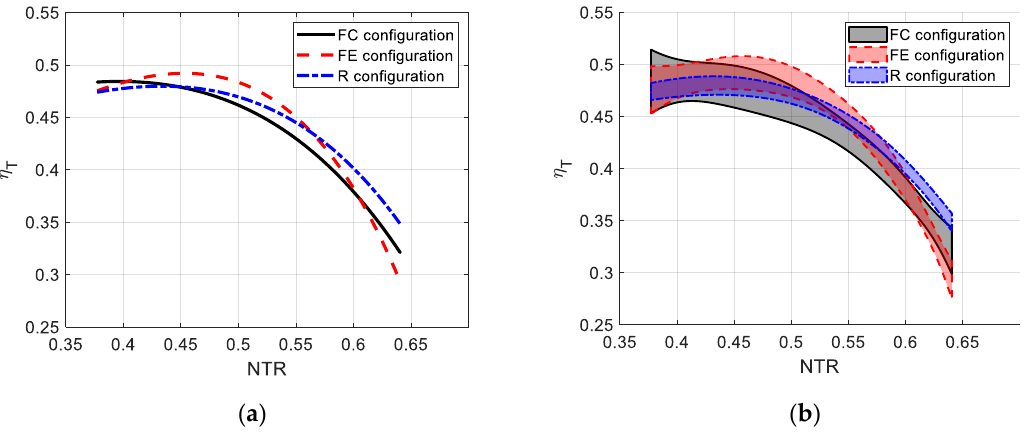
Figure 9. ( a ) NTR-η T regression curves and ( b ) prediction bound areas for tractor configurations FE, FC and R. Regression coefficients are listed in Table 9. The lower and upper net traction ratio values for the models are 0.40 and 0.64, respectively.